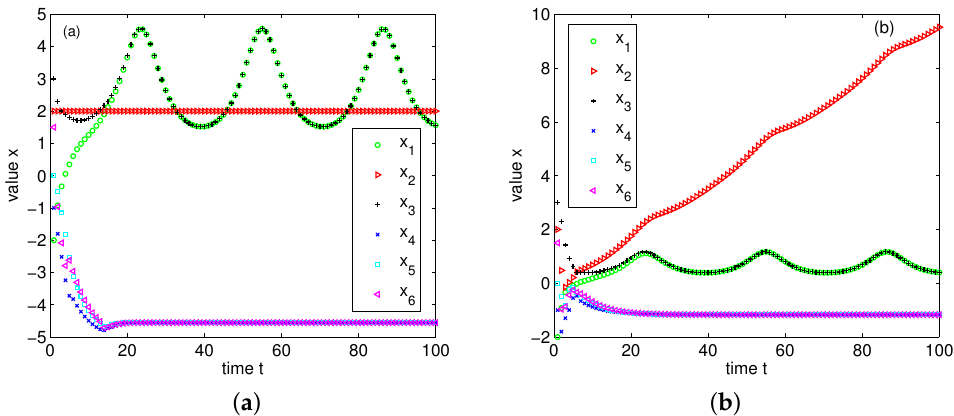
Figure 2. Time evolution of the agents’ values: ( a ) v 2 maintains its value and ( b ) v 2 updates its value according to x 2 ( t + 1 ) = ( x 1 ( t ) + x 3 ( t ) + x 4 ( t ) + x 6 ( t )) /4 + t /10.